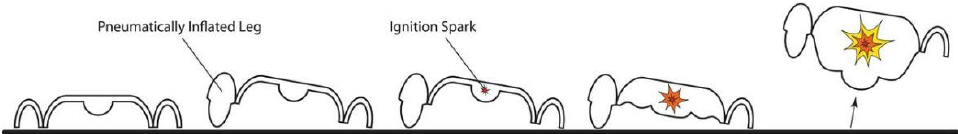
Figure 4. Untethered jumping robot powered by combustion [82], reproduced with permission from [82], 2015, American Association for the Advancement of Science.